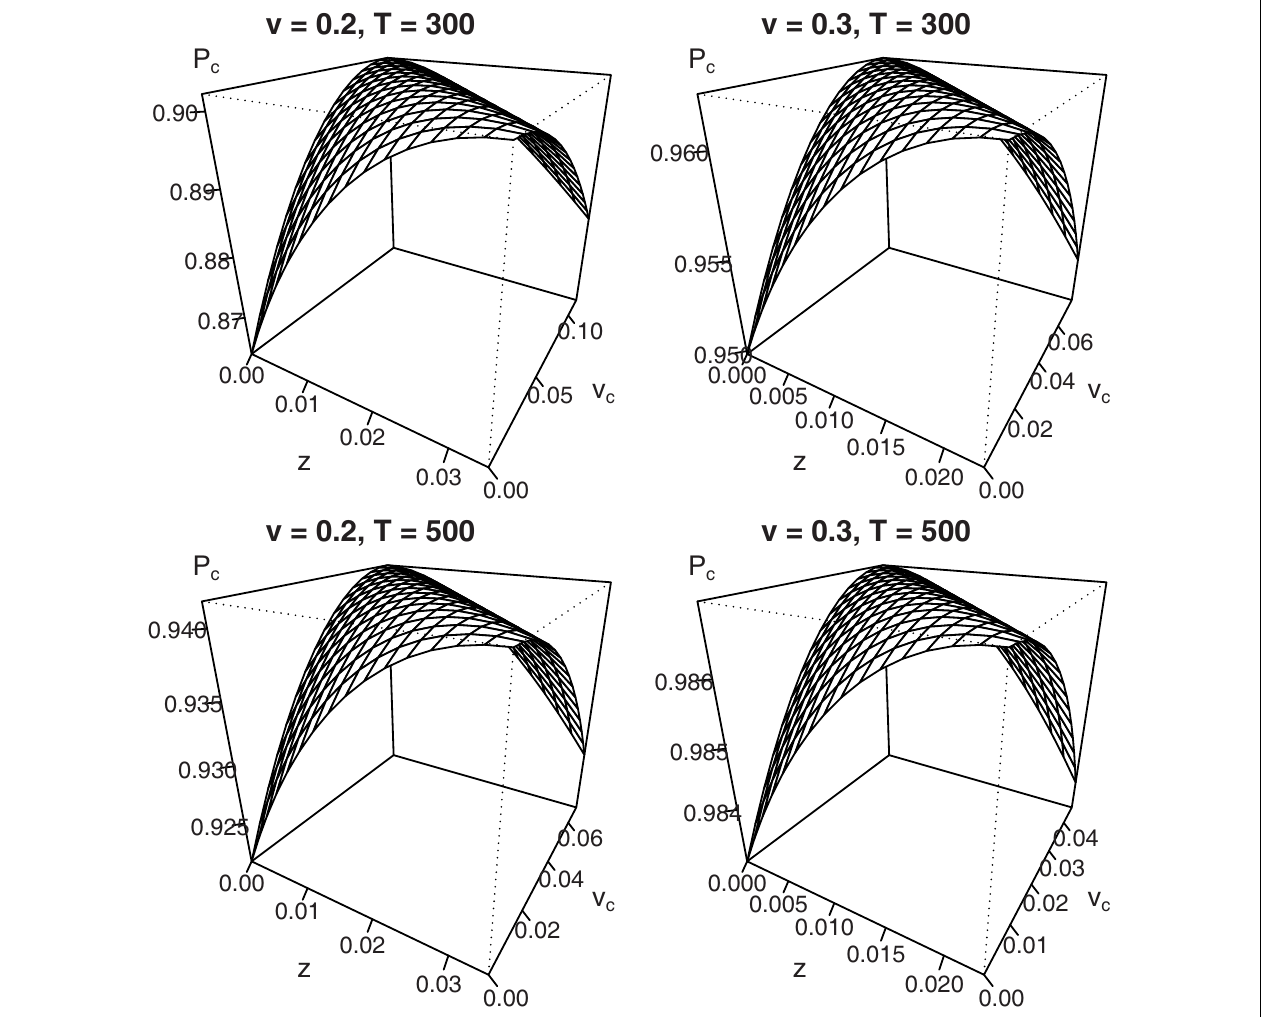
FIGURE 4 | Mean percentage correct for fixed difficulty ( η = 0) in the interrogation paradigm for different combinations of starting point z and shift in mean drift rate v c . Due to the trade-off (cid:5) z = (cid:5) v c · T , no unique maximum